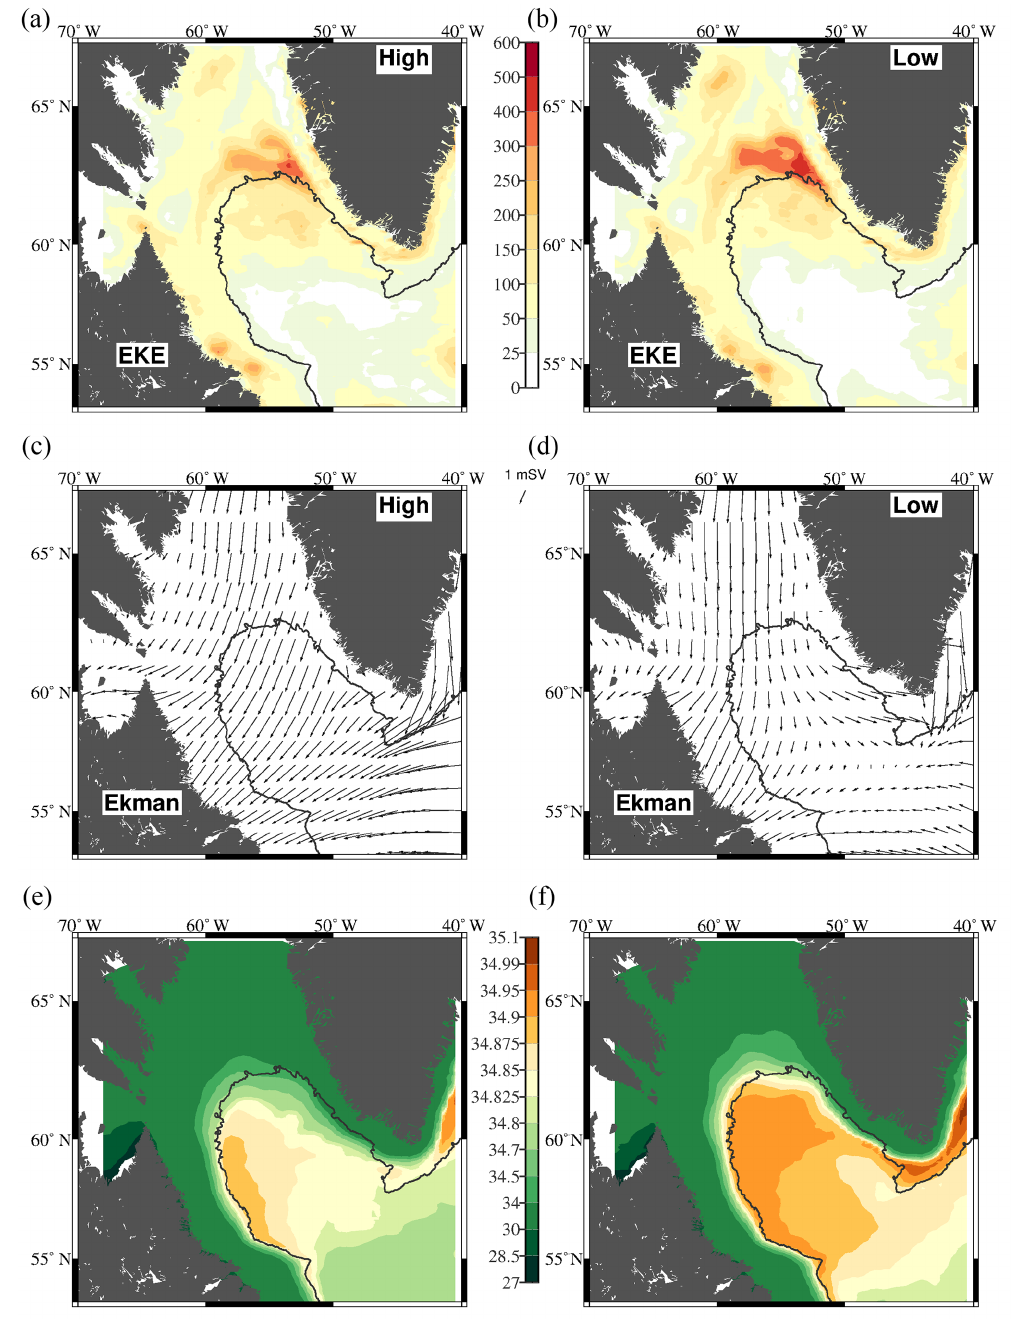
Figure 11. (a, b) The mean surface EKE (cm 2 s − 2 ) during months with an anomalously high and low number of crossings. (c, d) Same as (a, b) but for the Ekman transport. (e, f) Same as (a, b) but for the model salinities of the top 30m.